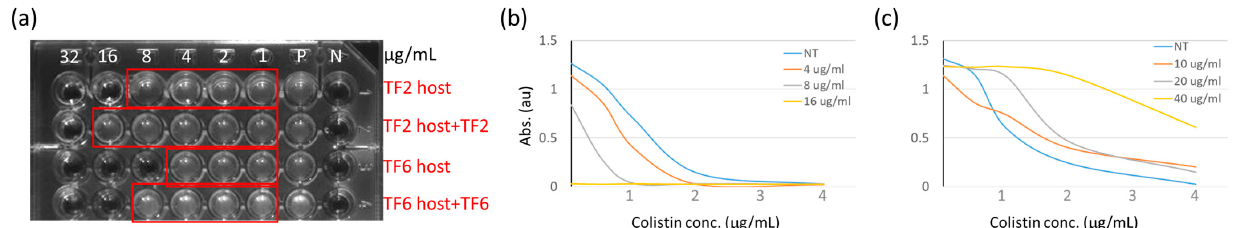
Figure 2. Reducing bacterial susceptibility to endolysin-derived P3 peptide and colistin by tail fiber (TF) treatment. ( a ) TF treated bacteria show resistance to P3 containing culture medium. Various concentrations of P3 peptide were marked on a 96-well dish. TF treated hosts were found to be more resistant to P3 peptide than the untreated control. ( b ) Turbidity test (595 nm absorbance) to determine bacterial growth showed an additive effect in the suppression of A. baumannii . Curves of various colors represent the different P3 dosages which are showing on the indicated concentrations. ( c ) Protective effects were observed when presenting TF protein in A. baumannii culture medium. The dosages for TF protein are presented according to the mark for different